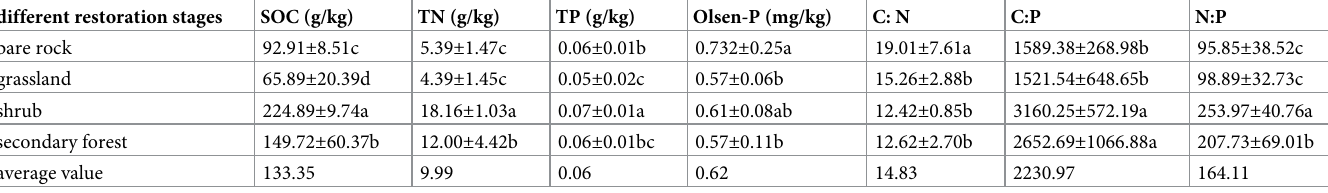
Table 2. The contents and stoichiometric ratios of soil C, N, and P in different stages of restoration from karst rocky. different restoration